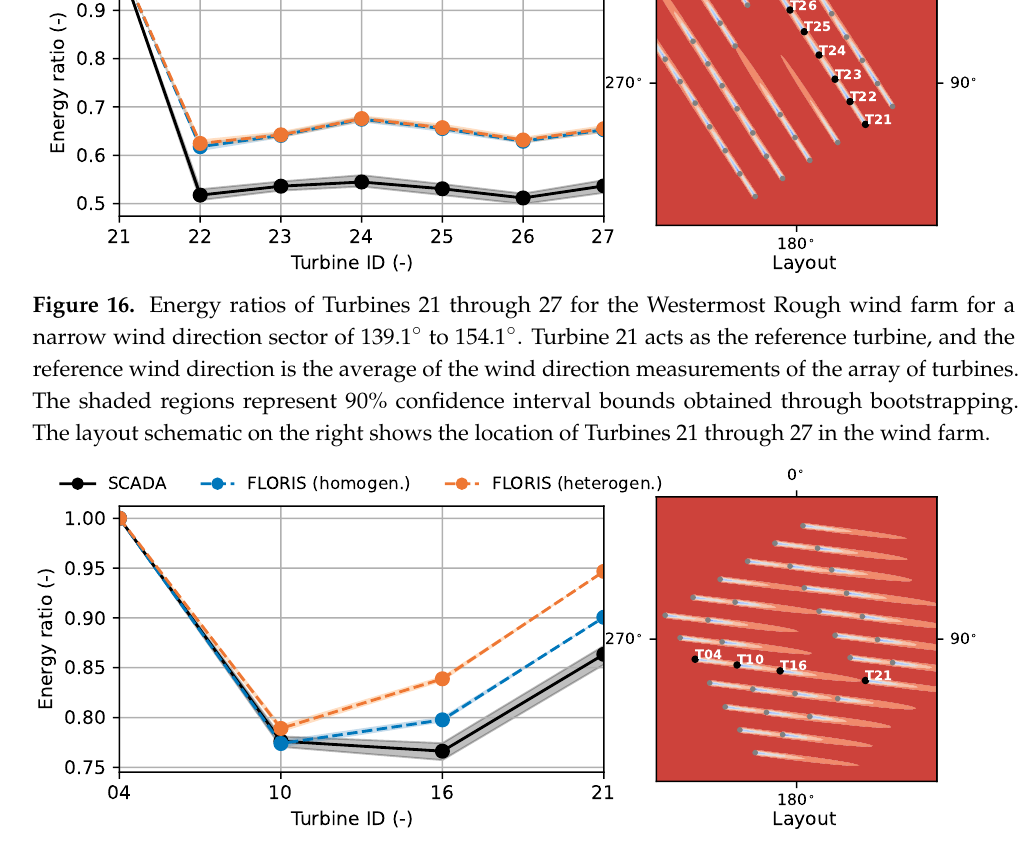
Figure 17. Energy ratios of Turbines 4, 10, 16, and 21 for the Westermost Rough wind farm for a narrow wind direction sector of 269.6 ◦ to 284.6 ◦ . Turbine 4 acts as the reference turbine, and the reference wind direction is the average of the wind direction measurements of the array of turbines. The shaded regions represent 90% confidence interval bounds obtained through